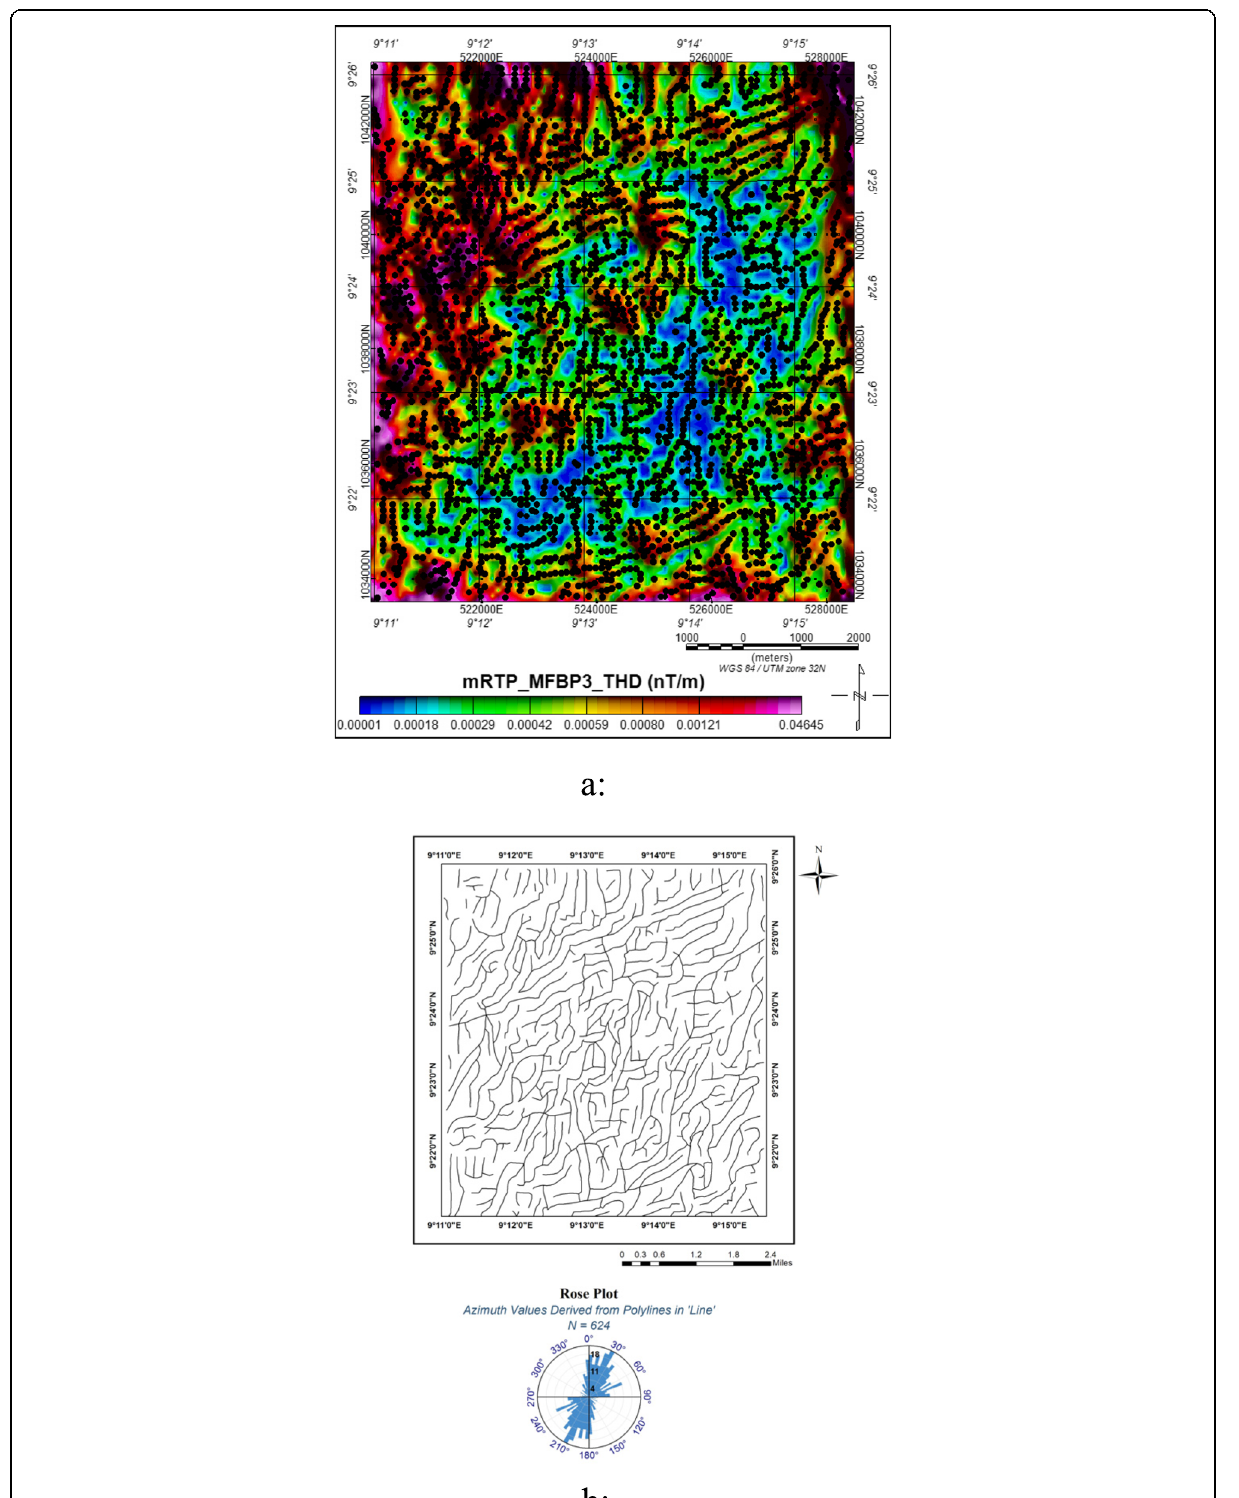
Fig. 22 a Edge enhanced total horizontal derivative of layer 3. b Linear/curvilinear map of layer